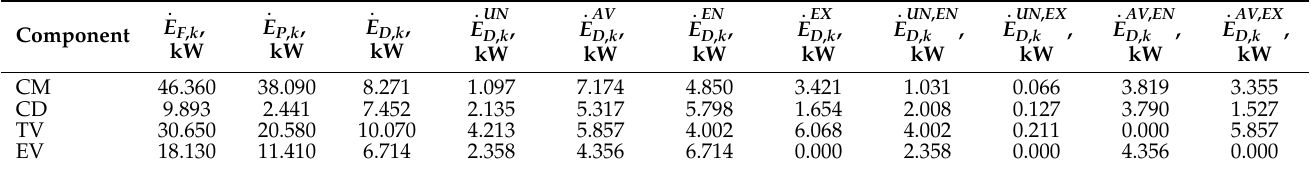
Table 6. Results obtained from the conventional advanced exergy analysis [2].